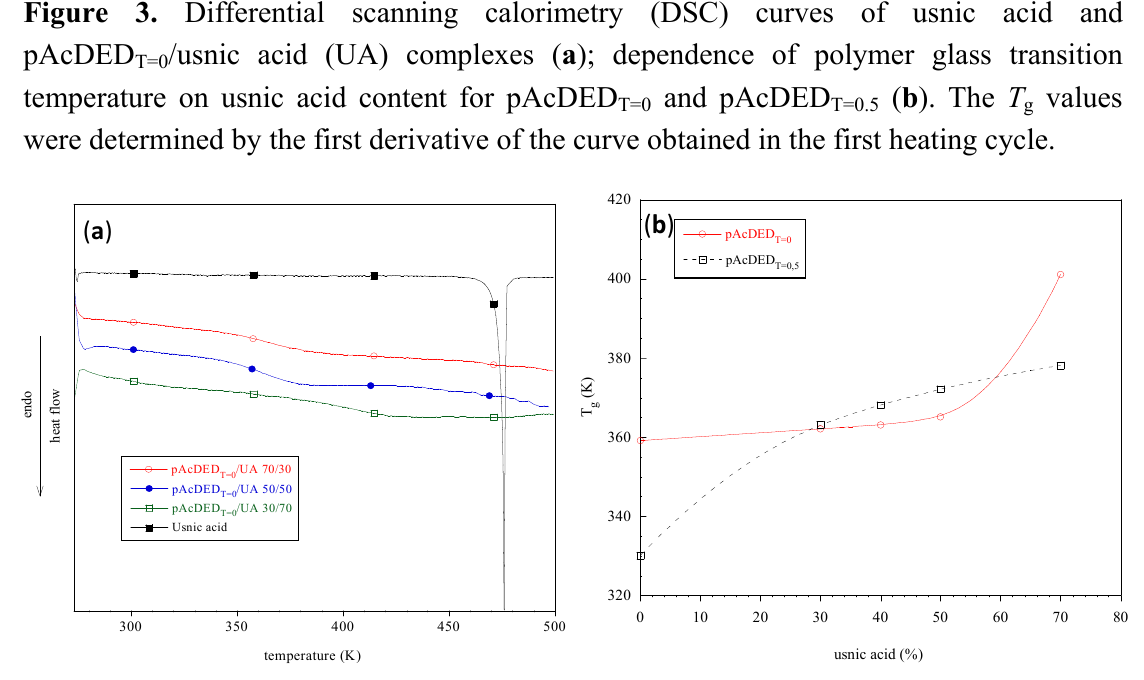
and pAcDED ( b ). The T values T=0 T=0.5 g